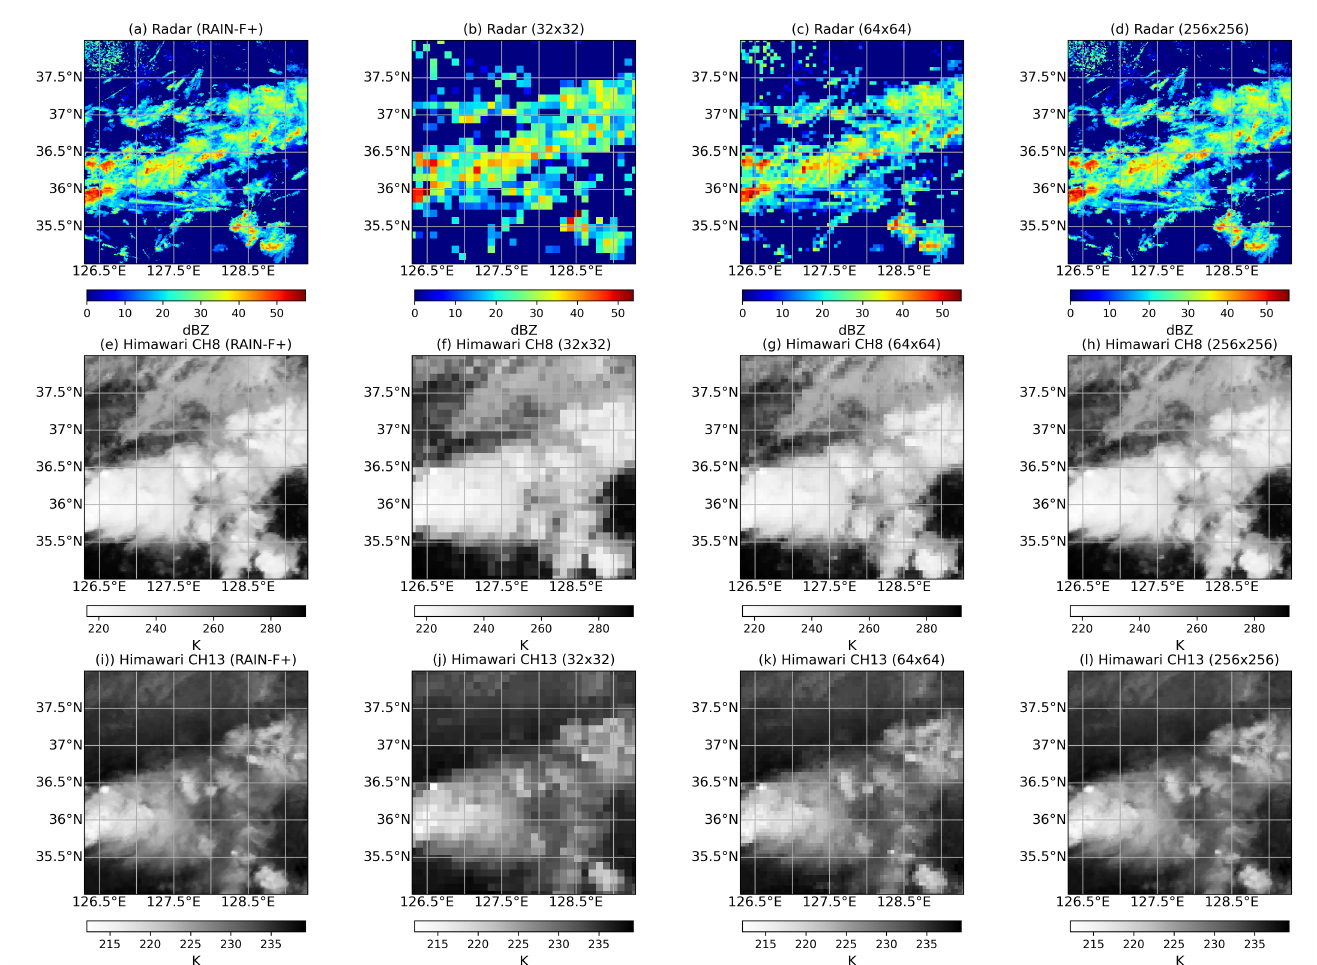
Figure 6. The input images at different resolutions for the radar and Himawari-8